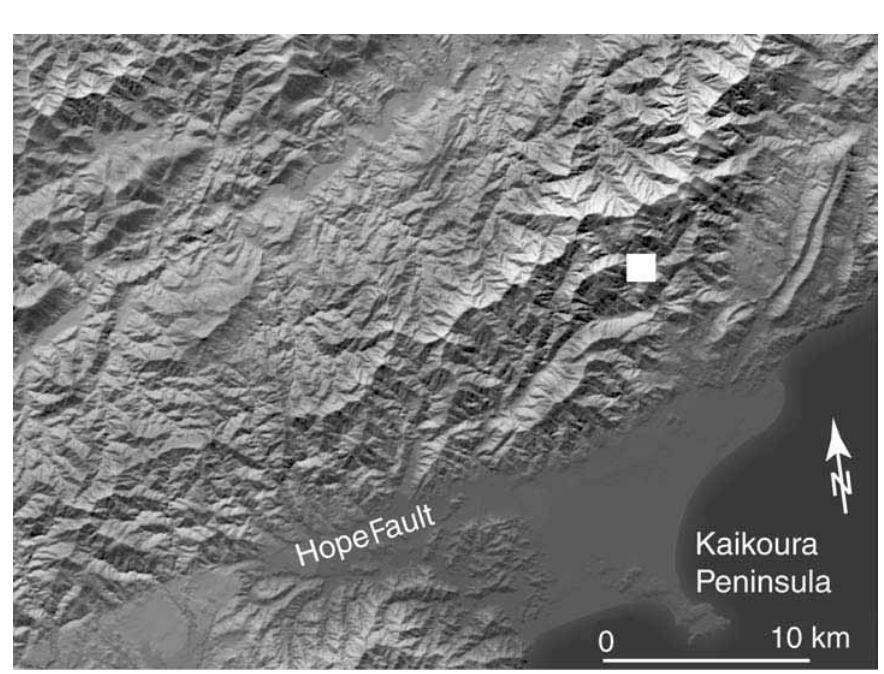
Fig. 2. The Hope Fault stands out on this digital image because of its rapid slip rate. The Seaward Kaikoura Range rises 1500 to 2600 m above the Pacific Ocean. Location of the Barretts landslide is shown by the white square. Image provided courtesy of Scott Miller and Manaaki Whenua Landcare Research, New